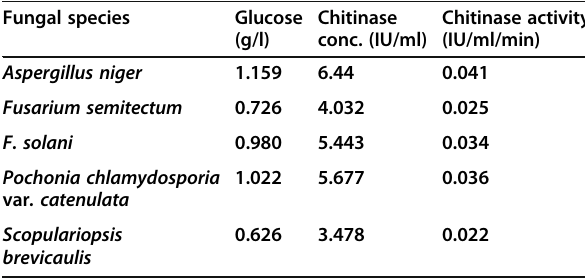
Table 3 Concentration of chitinase produced by fungi isolated from insects Fungal species Glucose